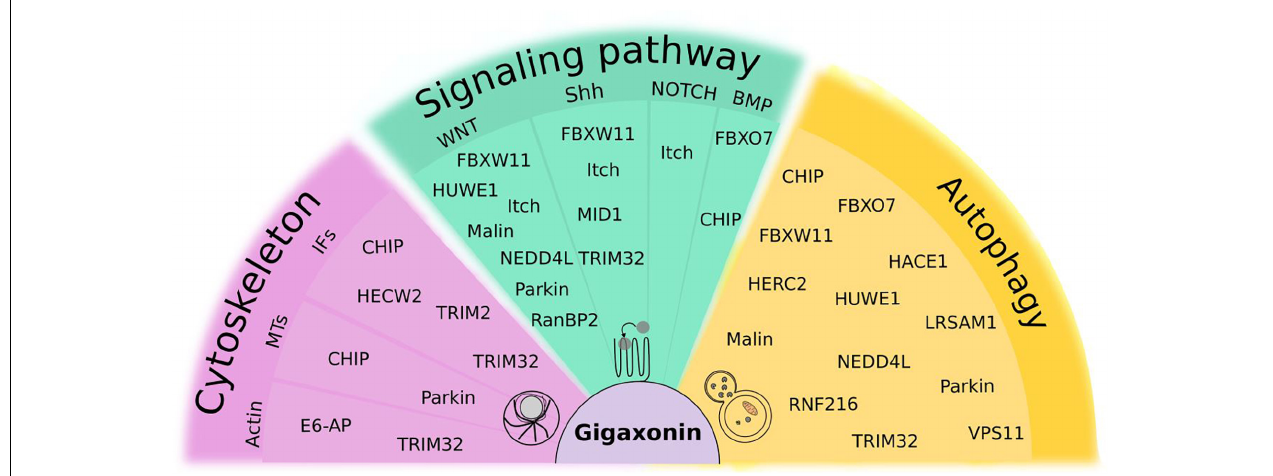
FIGURE 8 | Focus on ubiquitin(like)-dependent regulation of cellular mechanisms shared by Gigaxonin and other E3 ligases. Cytoskeleton comprises actin, microtubules (MTs) and Intermediate Filaments (IFs). Signaling pathways, selected from their roles in spinal cord development and maintenance include WNT, Sonic Hedgehog (Shh), NOTCH and Bone Morphogenetic Protein (BMP). For Fibroblast Growth Factor (FGF) and Retinoic acid (RA), no function of E3 ligases was reported to our knowledge. As substantial proportion of E3 ligases (30%) control the autophagy pathway. Some E3 ligases act at multiple levels within the same pathways (like Itch, NEDD4L), and 23% of them exhibit functions in different pathways, with Gigaxonin, TRIM32, and CHIP crossing all pathways.